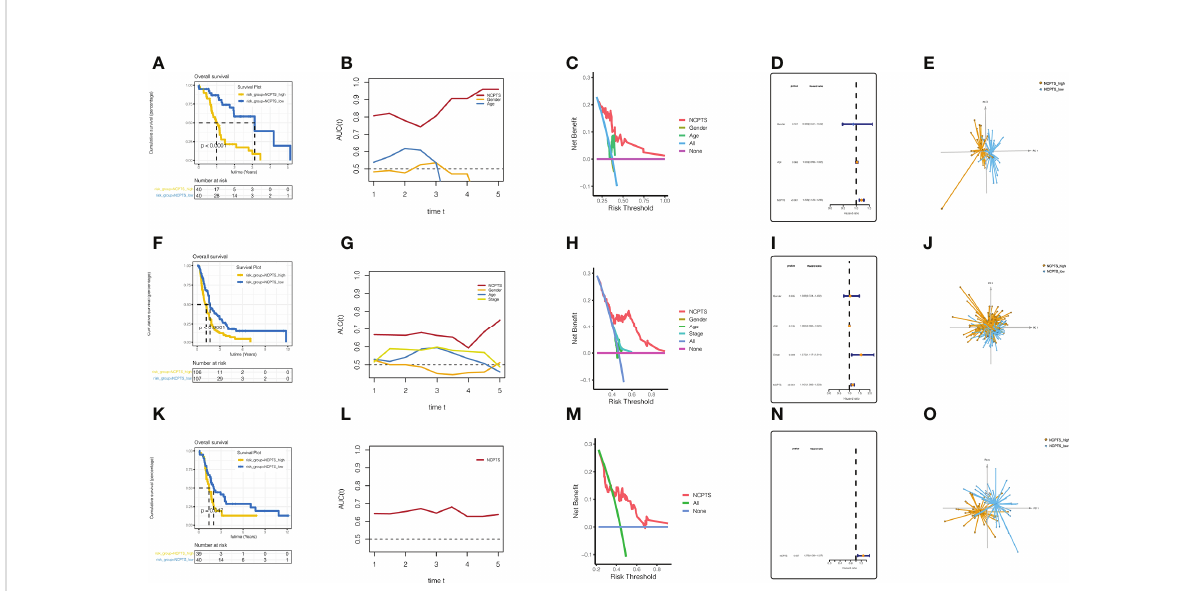
FIGURE 5 External validation and evaluation of the prognostic model. (A – E) Validation and evaluation of the model in the PA-AU cohort. (F – J) Validation and evaluation of the model in the PA-CA cohort. (K – O) Validation and evaluation of the model in the GSE85916